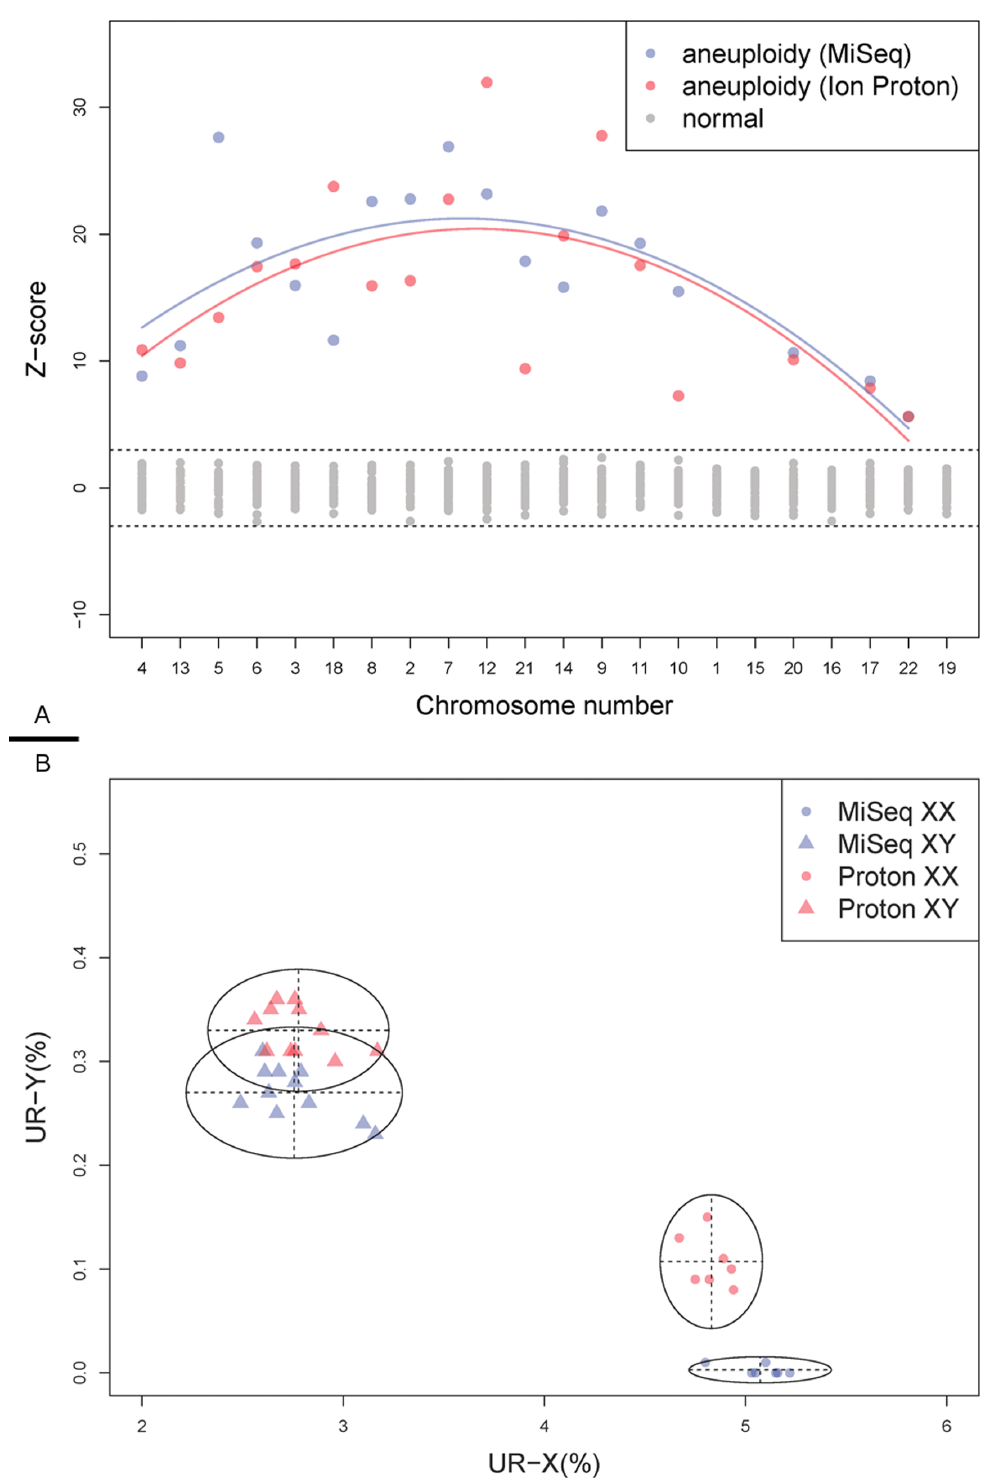
Figure 3. Performance of aneuploidy detection and Sex estimation using 90 K reads from two different platforms. A, Aneuploidy detection result. The z-scores (y-axis) of all 22 autosomes (x-axis, sorted by GC content) for the 18 SA samples are shown in this figure. The cut-off value was set as 6 3 (dash line). Aneuploidies signals detected by these two platforms were color-coded (red for MiSeq and blue for Ion Proton) respectively, and negative signals were labeled in grey. The curve was fitted between the z-scores and chromosomal GC content. B, Sex detection with UR-X% and UR-Y%. Using UR-X% (x-axis) and UR-Y% (y-axis), these 18 samples were grouped into two clusters by Gaussian finite mixture model fitted by EM algorithm. These color-coded (red for MiSeq and blue for Ion Proton) scatters with different shapes were label according to the fetal genders (circle for XX and triangle for XY). Each cluster is grouped according to sex detection.